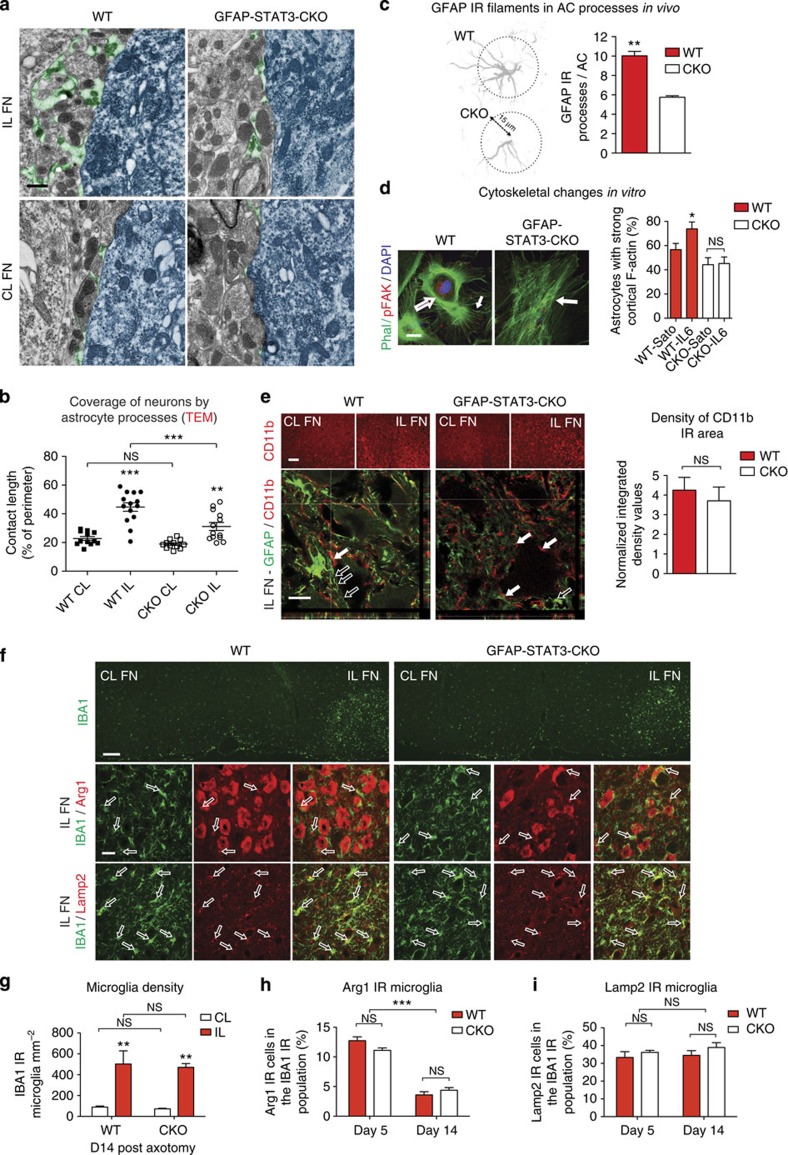
STAT3 mediates reactive AC process formation.(a,b) Differential increase in perineuronal AC process availability 14 days post facial nerve transection in WT and CKO mice. (a) Electron micrographs of AC endfeet (green) along the neuronal membrane (blue) in the IL and CL FN. (b) Ultrastructural analysis: percentage of neuronal perimeter contacted by AC endfeet (CL n=12, IL n=14 cells, ***P<0.001, **P<0.01, one-way analysis of variance (ANOVA) P<0.0001). (c) Mean number of AC processes that are GFAP IR 15 μm beyond the soma (n=3 mice, 63–90 cells in total, **P=0.009, t-test). (d) In vitro examples of activated ACs displaying cortical F-actin fibres (phalloidin, empty arrow) with connections to radial filaments (small arrow) and phosphorylated focal adhesion kinase (pFAK) 24 h after IL-6 treatment. Non-activated ACs retain their flat morphology with mostly parallel filaments (full arrow). Mean numbers of WT or CKO ACs that retained their activated phenotype 24 h after activation by IL-6 or in serum-free medium (Sato) (n=3 experiments per replicate cultures, *P=0.043, t-test). (e) CD11b immunolabelling in the CL and IL FN in WT and CKO mice. Lower panel represents confocal images of the axotomized FN. In WT mice, CD11b IR structures (full arrows) appear to intermingle with processes that are strongly positive for GFAP (empty arrows). Mean density values for CD11b IR areas normalized to the CL FN in WT and CKO mice at day 14 post axotomy. (f) Illustrations of IBA1 IR-activated microglia in IL FN (green) and of its subtypes co-labelled (arrows) for markers, Arg1 or Lamp2 (red) in WT and CKO mice at day 14 post axotomy. (g) Means of cell densities for IBA1 IR-activated microglia at day 14. (h,i) Means of percentages of Arg1/IBA1 (h) or Lamp2/IBA1 (i) double-labelled microglia/macrophages over the total number of IBA1-positive cells in the IL FN (day 5 n=4 and day 14 n=3, ***P<0.001, **P<0.01, one-way ANOVA). Scale bar, 0.25 μm for a; 20 μm for d; 100 and 20 μm for e; 200 and 25 μm for f. Data represent mean±s.e.m.